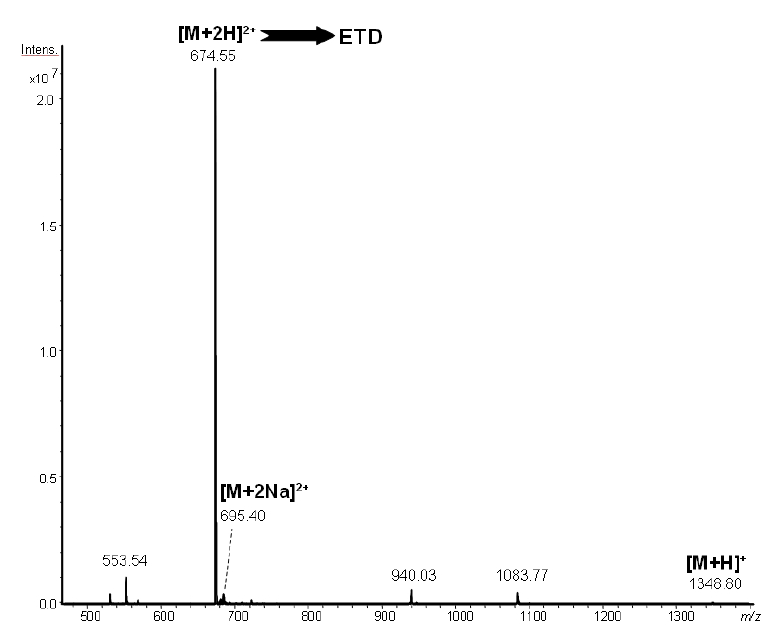
Figure 1. (+) NanoMate-HCT MS 1 of Substance P. Concentration 0.1 pmol µL -1 in 98% formic acid. Acquisition time 10